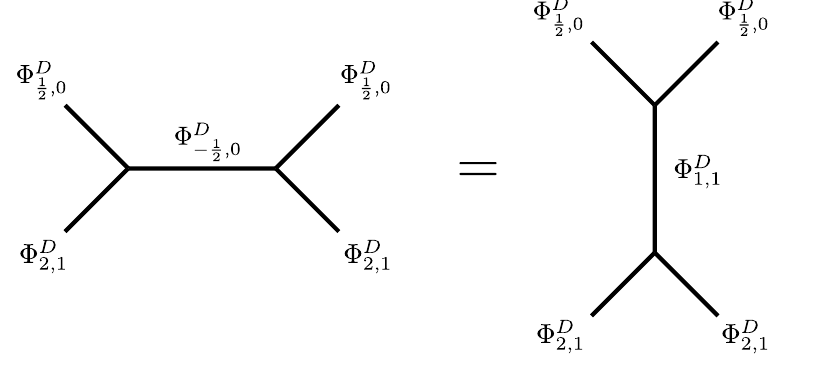
in the t -channel and the corresponding amplitude a ( t ) 1 , 1